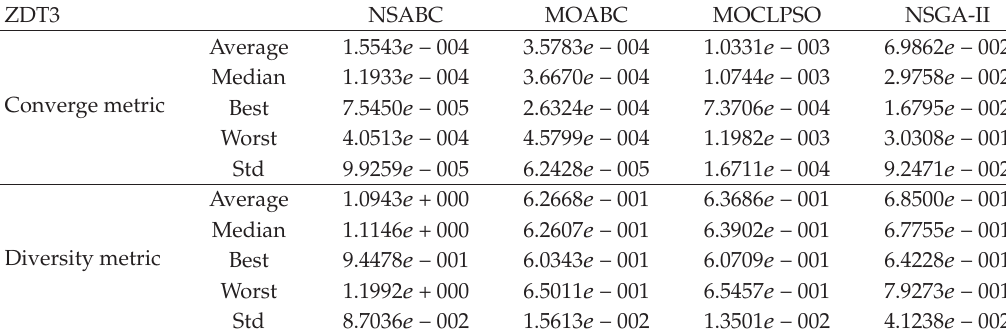
Table 10: Comparison of performance on ZDT3 after 20000 FEs.